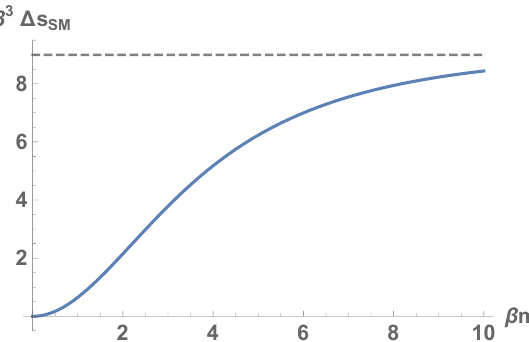
Figure 10 . The change in the entropy density ∆ s SM /T 3 (solid blue) of the standard model plasma across a nucleated bubble as a function of the ratio of the top mass (in the broken phase) and the temperature, βm t = m t ( φ 0 ) /T . The maximum amount by which the entropy density can change is 41 π 2 T 3 / 45 , which is reached when βm t → ∞ (horizontal